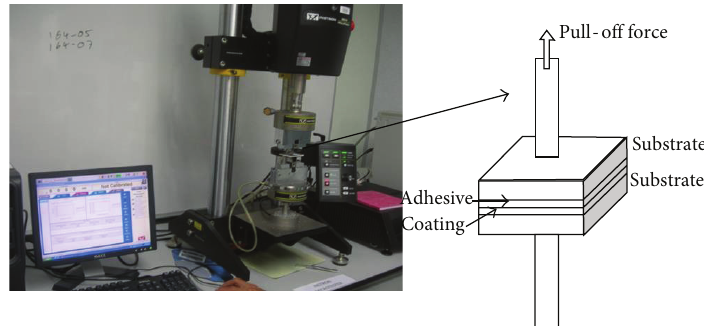
Figure 1: The setup for the measurement of adhesion